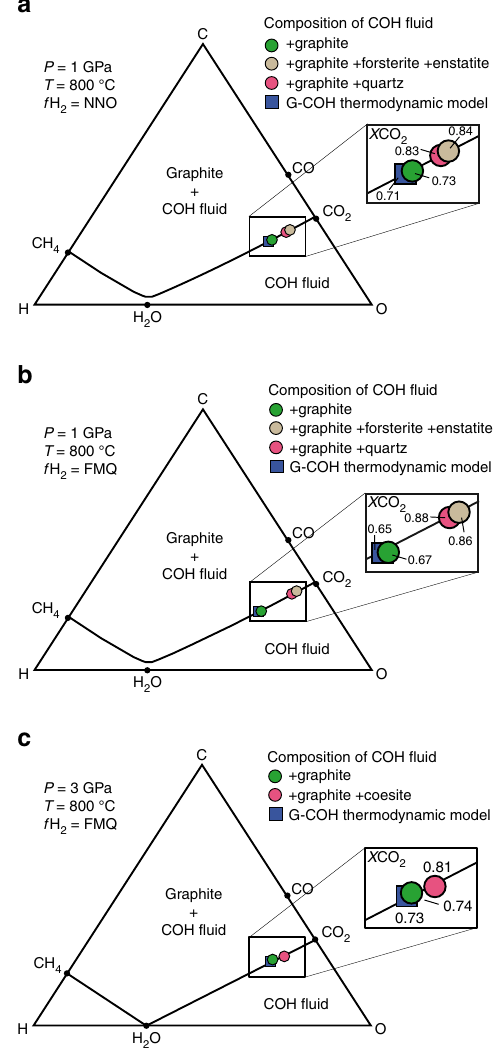
Fig. 1 Measured volatile composition of graphite-saturated fl uids interacting with silicates. C – O – H diagram showing the volatile composition of fl uids, measured by quadrupole mass spectrometry, synthesized at P = 1 GPa, T = 800 °C and f H 2 NNO a and f H 2 FMQ b conditions, and P = 3 GPa, T = 800 °C and f H 2 FMQ c in equilibrium with graphite only (COH system; green dots ), graphite + forsterite + enstatite (MgO – SiO 2 – COH system; ochre dots ) and graphite + quartz (SiO 2 – COH system; pink dots ). The graphite- saturation surfaces, i.e., the loci of points representing all possible compositions of graphite-saturated COH fl uids (G-COH) at fi xed P , T and variable f O 2 conditions, calculated by thermodynamic modeling 45 , are shown for comparison ( black curves ) along with the volatile fl uid composition predicted by the EoS of Zhang and Duan 46 using the H 2 fugacity coef fi cient of Connolly and Cesare 45 ( blue squares ; Methods, Supplementary Fig. 2 and Supplementary Table 2 for details). Compared to the pure COH system, the X CO 2 [ = CO 2 /(H 2 O + CO 2 )] of the fl